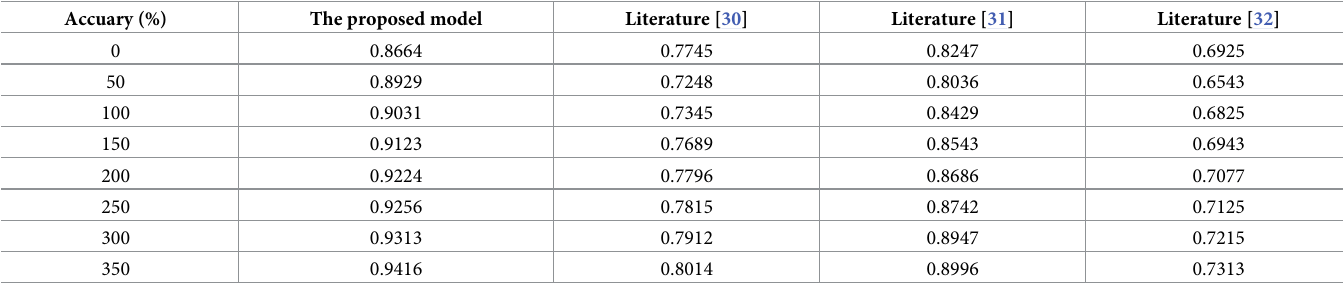
Table 1. Accuracy comparison of different